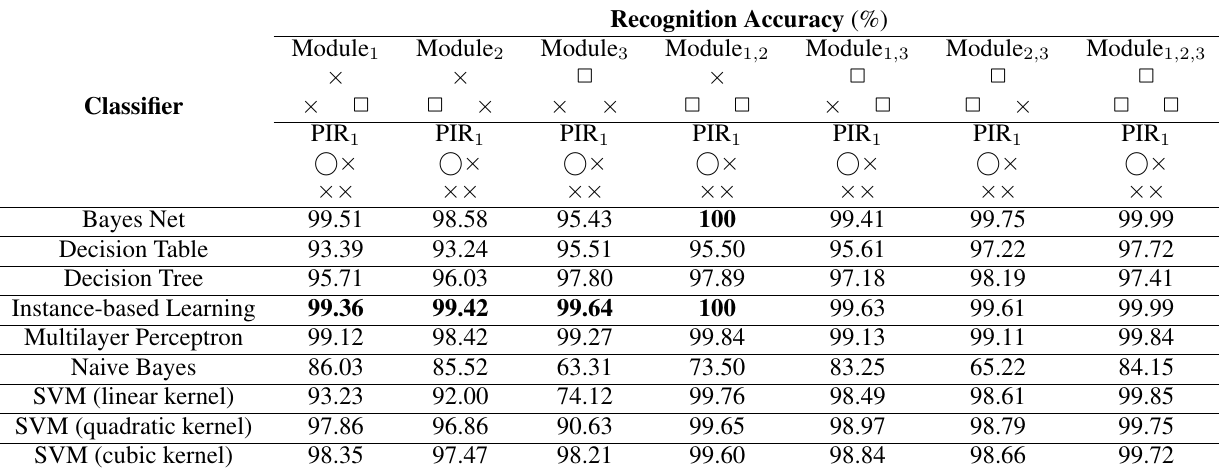
Table 2. Comparison of the recognition accuracy (%) of classifying walking directions based on the raw data set (PIR ) with respect to the number of modules. 1